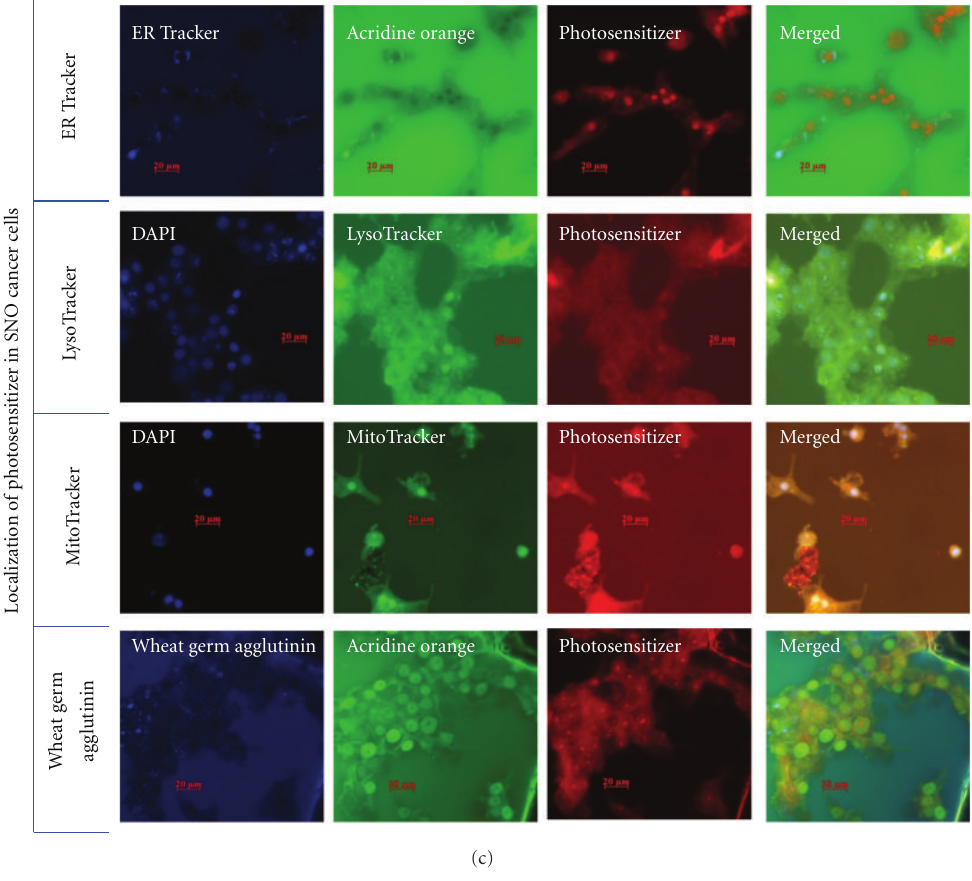
Figure 3: Live imaging of the PS in (a) A549, (b) MCF7, and (c) SNO cancer cells after PDT treatment with staining the ER, lysosomes, mit- ochondria, and plasma membrane, showing the intrusion of the PS through the plasma membrane and its localization in di ff erent cell organelles inside the cancerous cell